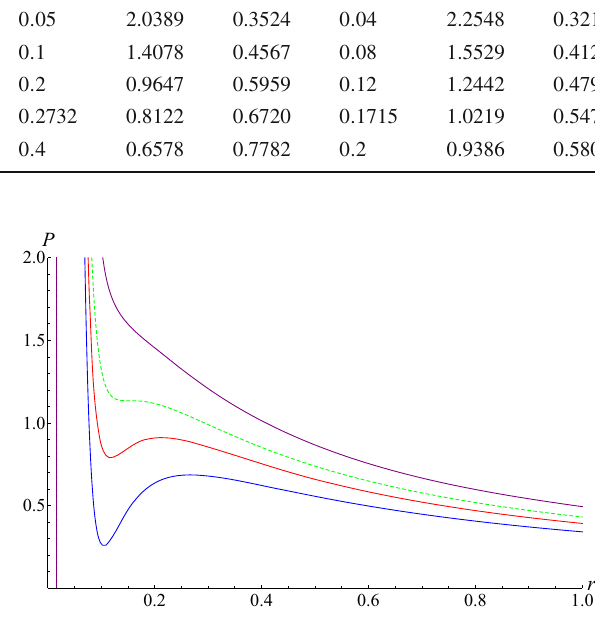
Fig. 10 The pressure is plotted in terms of the event horizon radius r + , under the different values of the temperature, at m = c = c 1 = c 2 = 1 and k = 0 . 1. The blue, red, dashed green and purple curves correspond to T = 0 . 9, 1, 1 . 0764 ( T c ), 1 . 2,